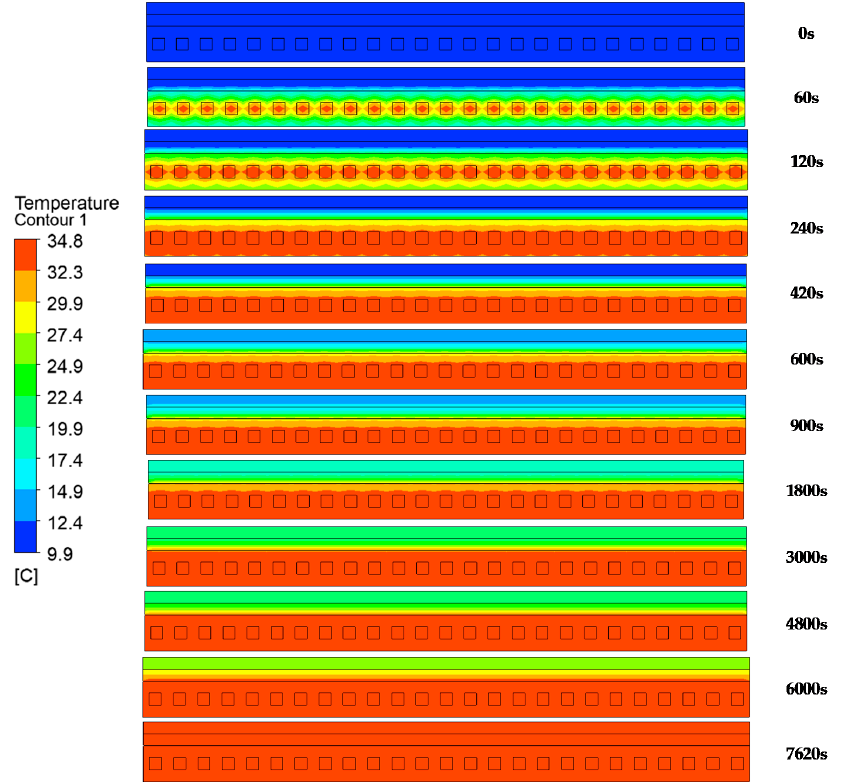
Figure 8. A section through the PCMHPHS during the heating phase.